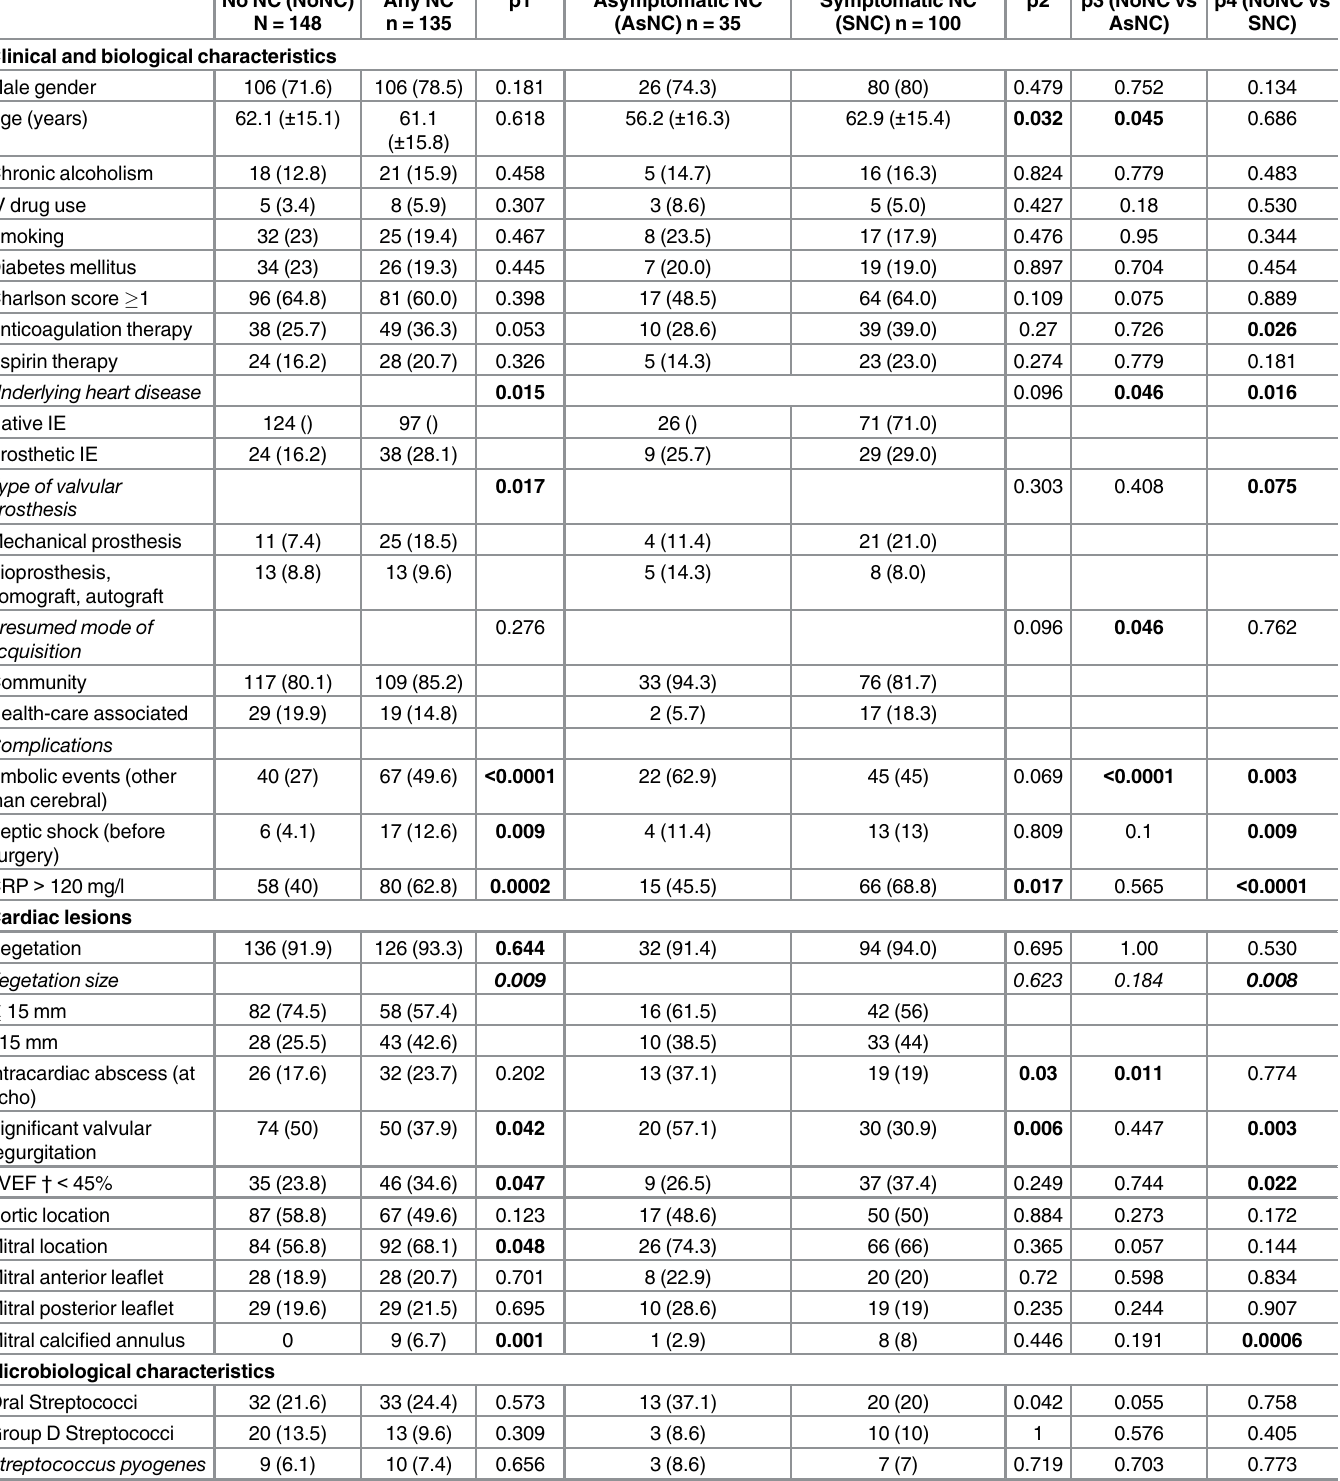
Table 1. Patient characteristics according to the absence or the presence of neurological complications (NC) either asymptomatic or